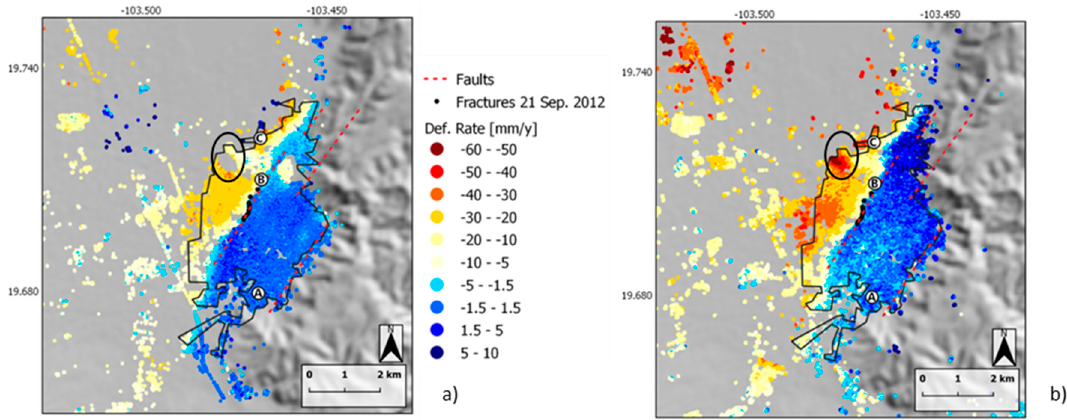
Figure 4. Deformation rate maps from the 2016–2018 S1 dataset (ascending path). PS ( a ) and SBAS ( b ) techniques results. The white circles indicate the selected sites individuating different displacements rates: (A) stable; (B) intermediate / fractured; (C) highest values. The black ellipses surround a particular area of CG that will be discussed in the Discussion section.